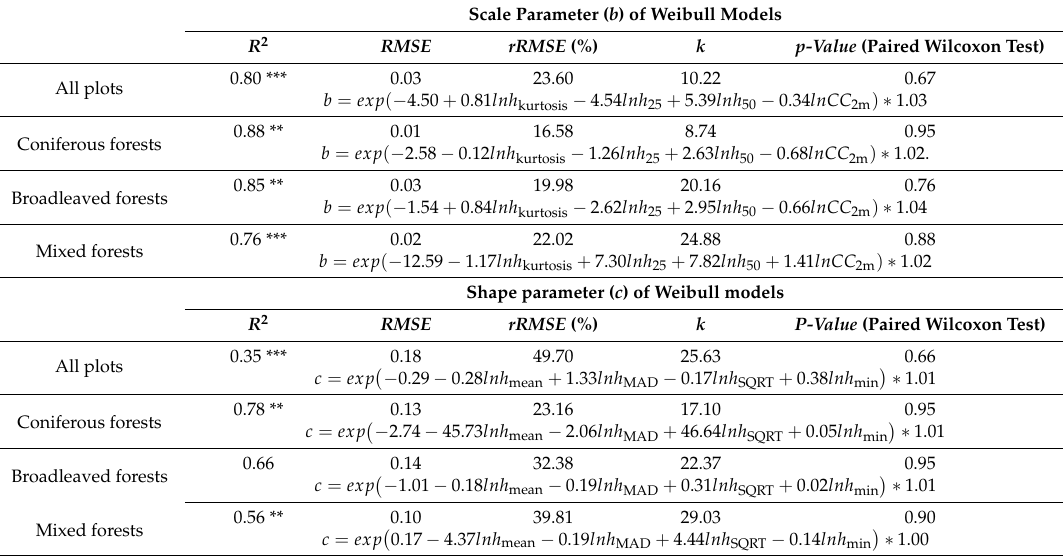
Table 3. A summary of statistics for parameter prediction method (PPM) models of the Weibull scale ( b ) and shape ( c )